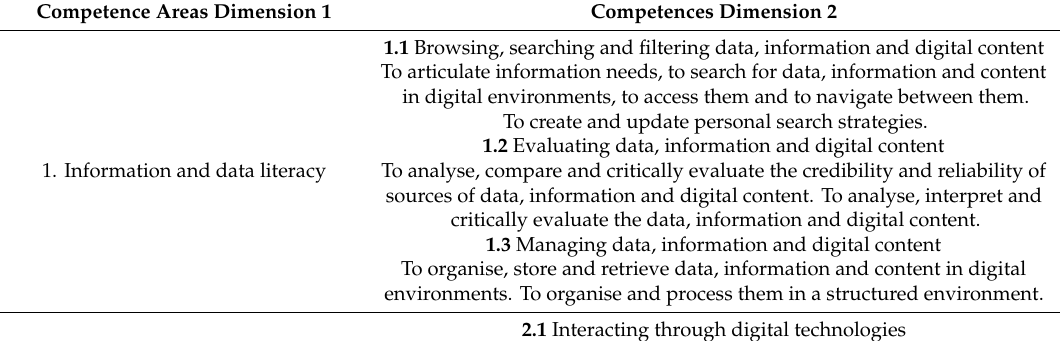
Table A1. DigComp 2.0-the Conceptual Reference Model–Dimensions